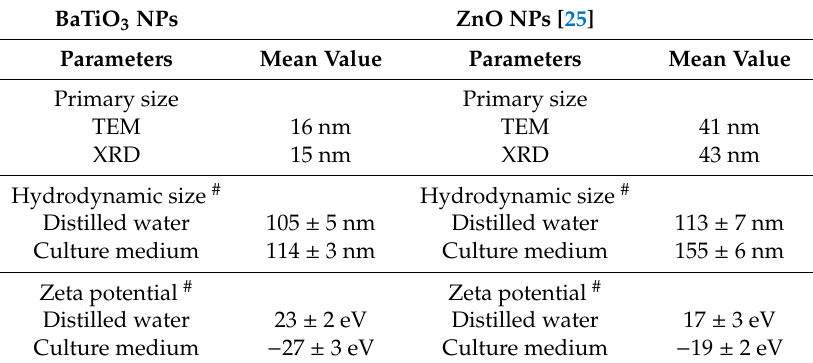
Table 1. Hydrodynamic size of BT NPs was 6–7 times higher than the size of nano-powder (primary size) calculated from XRD and TEM. Higher hydrodynamic size of BT NPs was due to the tendency of NPs to agglomerate in aqueous medium [19]. Zeta potential results indicated that BT NPs suspended in water had positive surface charges, whereas BT NPs suspended in culture medium had negative surface charges. Negative surface charges of BT NPs in culture media could be due to adsorption of negatively charged proteins on the surface of NPs. Physicochemical characterization of ZnO NPs (positive control) in distilled water and culture medium is also given in Table 1 [25]. Table 1. Physicochemical characterization of BaTiO 3 NPs and ZnO NPs. Table 1. Physicochemical characterization of BaTiO 3 NPs and ZnO NPs.